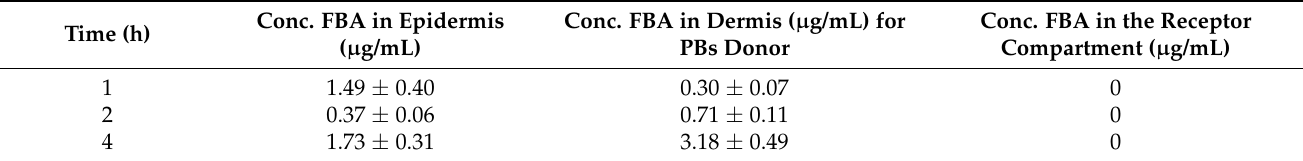
Table 1. FBA concentration in epidermis, dermis, and receptor compartment by time ( µ g/mL).